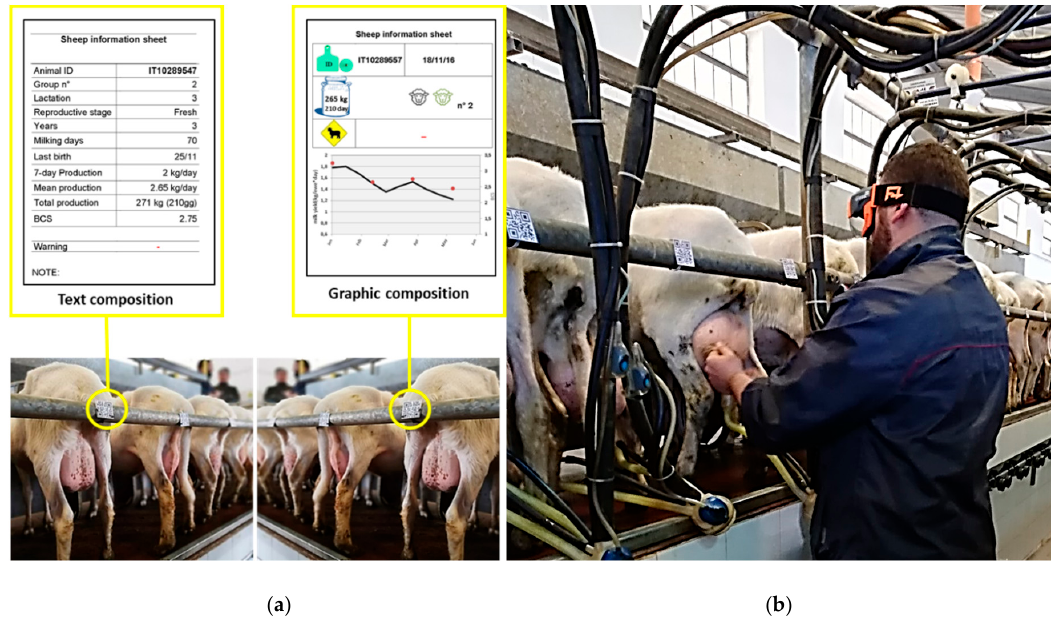
Figure 2. Sheep information sheet text and graphic format ( a ) and participant reading an animal’s information on GlassUp F4 smartglasses (F4SG) while milking ( b ).